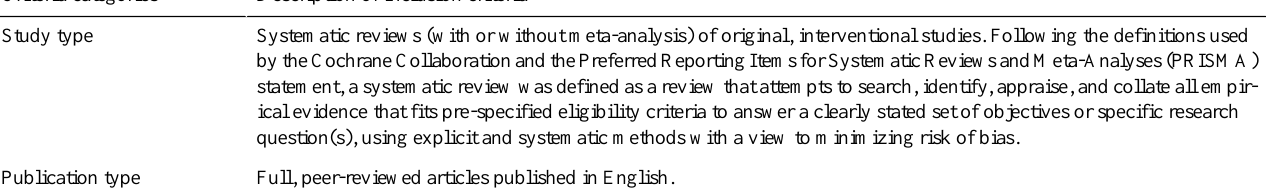
Table 1. Inclusion criteria for the selection of relevant systematic reviews. Description of inclusion criteriaCriteria